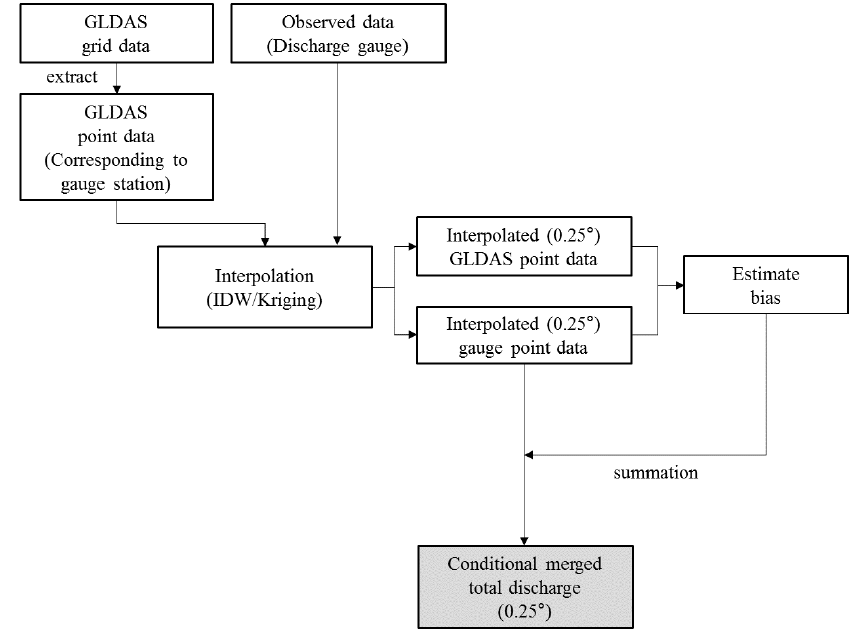
Figure 4. Flow chart of the conditional merging method. IDW: inverse distance weighting.